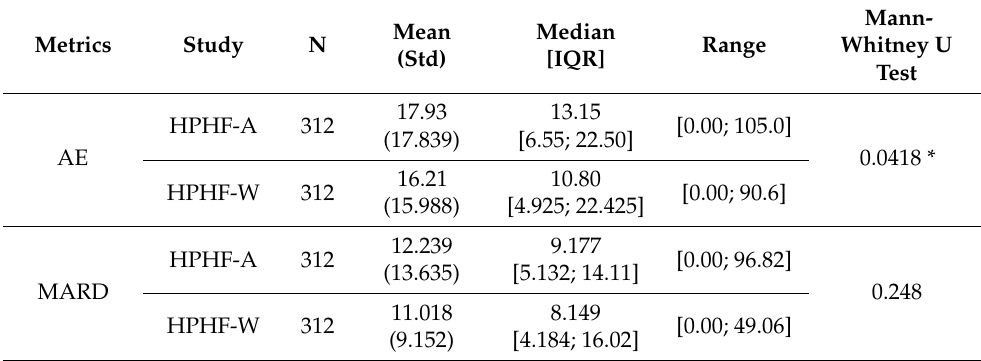
Table 2. Statistical main indicators for AE and MARD by study, besides the results of the comparison Mann–Whitney U test between studies for the variable of